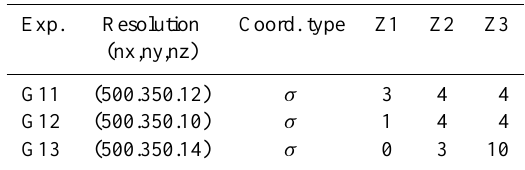
Table 2. List of the 3-D exps. (see Table 1 for details).